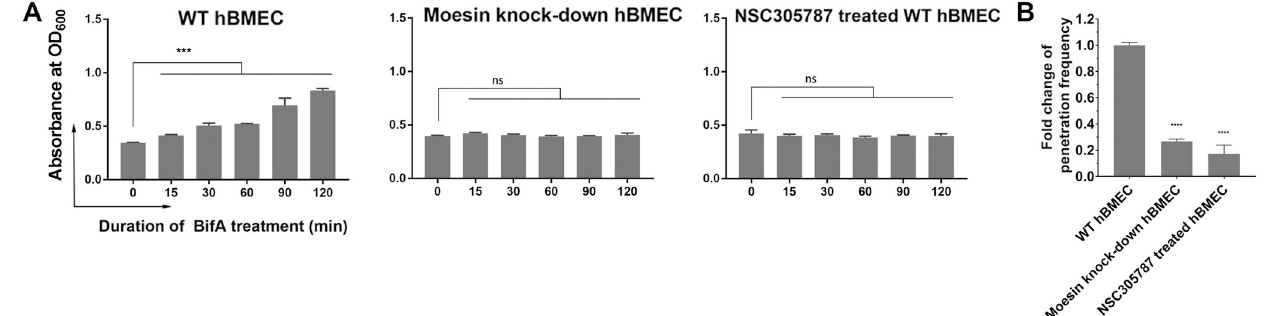
Fig 6. Inhibition of moesin phosphorylation or moesin knockdown block BifA disruption of monolayer barrier functions. (A) NSC305787 treatment and moesin KD prevent BifA-induced increase in monolayer permeability. Transwell-grown hBMEC monolayers were assayed for barrier integrity by Evans Blue dye (data represent 3 replicates /condition, ��� indicates p-value < 0.001 with t test). (B) NSC305787 treatment or moesin KD inhibit SEZ penetration of hBMEC monolayers. Transwell-grown hBMEC monolayers were infected with SEZ by inoculation into the upper chamber, and the proportion of bacteria in the lower chamber were quantitated by CFU plating (data represent 3 replicates /condition, ���� indicates p-value < 0.0001 with t test).